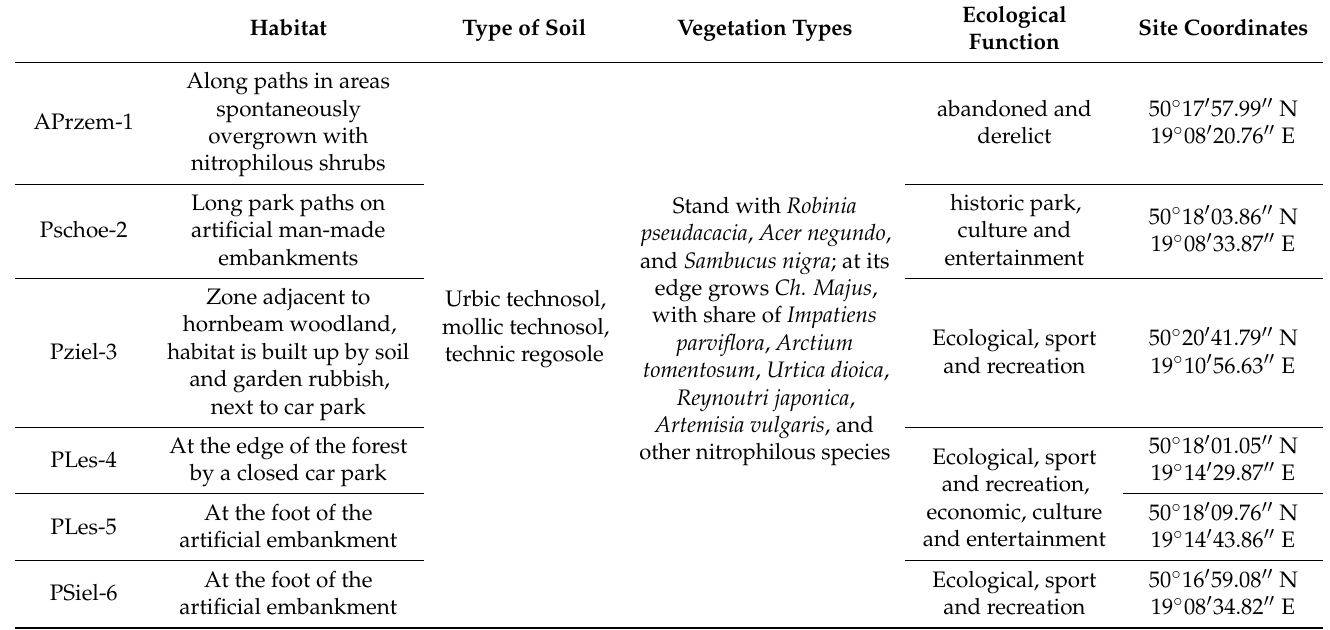
Table 1. The general features of analysed urban